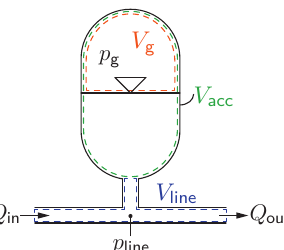
Figure 7: Definition of variables used for the simple pressure line